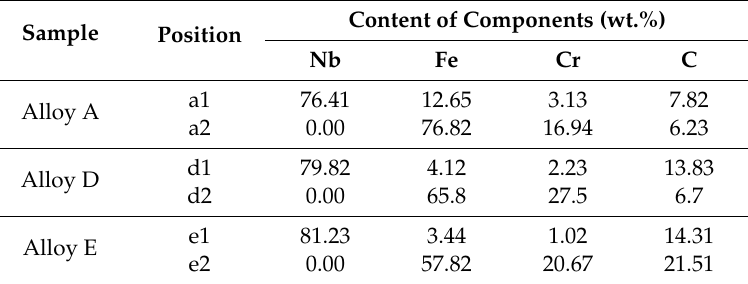
Figure 3. SEM images showing microstructure observed from the surface of various coatings with different Nb additions: ( a ) Alloy A; ( b ) Alloy B; ( c ) Alloy C; ( d ) Alloy D; ( e ) Alloy E. Table 2. EDS results of the points within Figure 2.